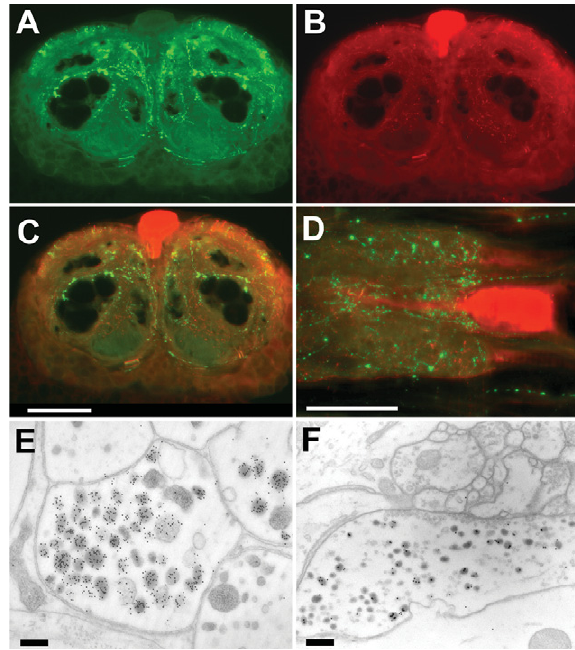
Figure 2. Immunostaining to PSK and octopamine in the sixth AG . ( A–C ) Frontal slices of the posterior part of the sixth AG, displaying PSK-ir (A), octopamine-ir (B), and merged ir (C). ( D ) Horizontal slice with double staining to PSK (green) and octopamine (red). Note that PSK-ir fibers occur near the soma of the octopaminergic DUM neuron. Bar, 100 m m. ( E , F ) Electron micrograms of two immuno-gold stained axon profiles of the sixth abdominal ganglion. Note the strongly stained granules in E. In these fibers no synaptic contacts were observed. Synaptic contacts are present in fibers showing weak staining (F). Bars, 100 m m